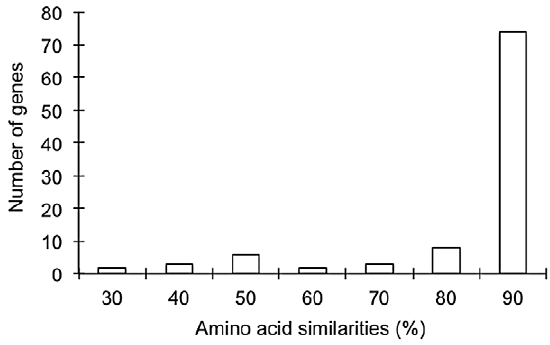
Figure 1. Distribution of the number of amino acid similarities in 98 Acroporamillepora – A.palmata homologous pairs.